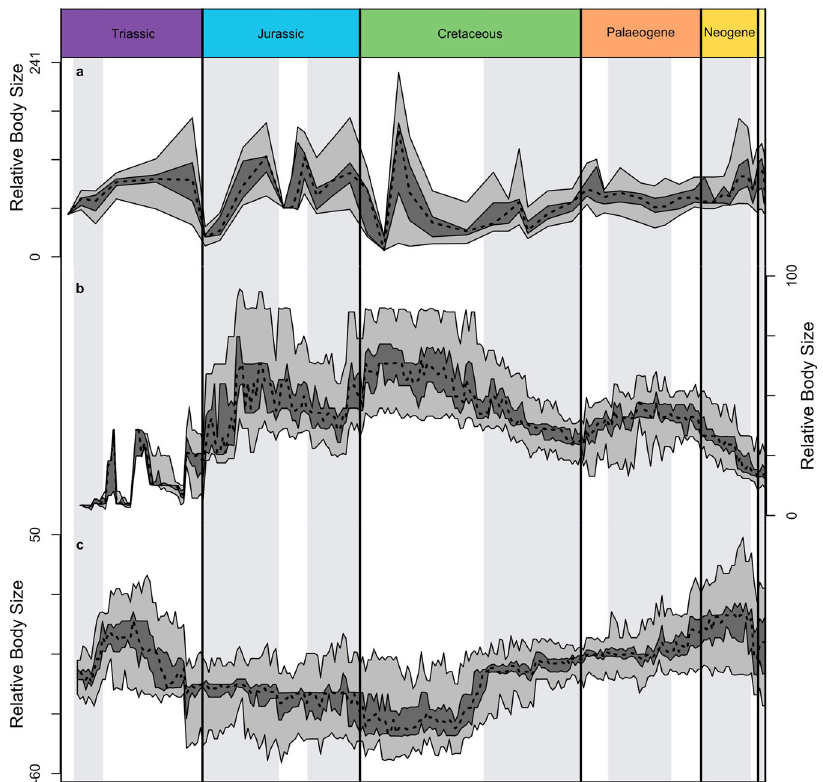
Fig. 4 Time-series representations of mean relative body size. Three approaches are shown: ( a ) actual taxa binned at the resolution of stratigraphic stages; ( b ) actual taxa plus ghost ranges inferred using branch lengths; ( c ) actual taxa plus ghost ranges plus phylogenetically reconstructed body size values of inferred common ancestors. Random 50% bootstrap samples were drawn over 100 iterations. The interquartile range of these iterations is shown in dark grey, the total range in light